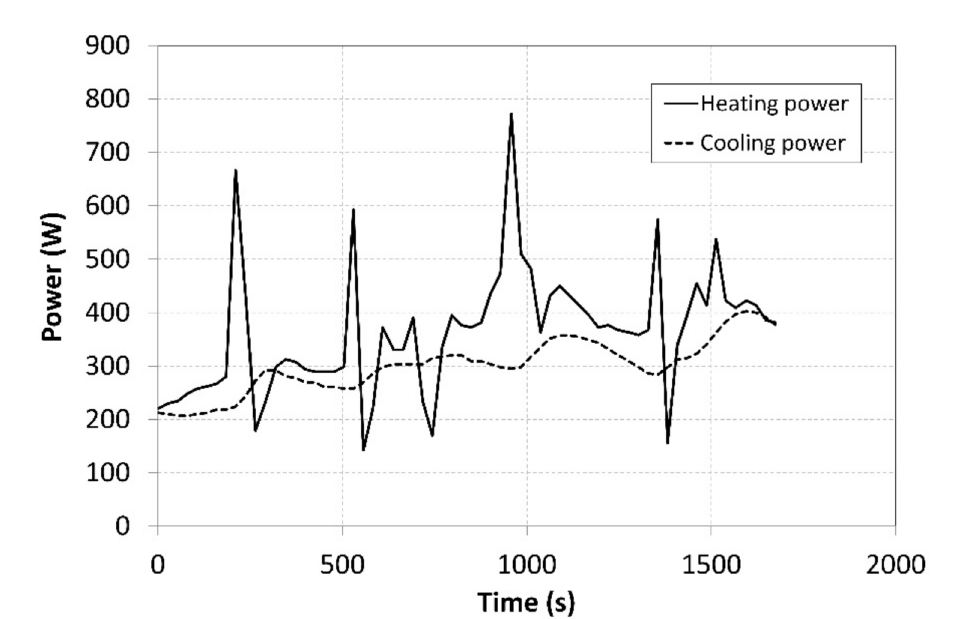
Figure 12. Cooling and heating powers supplied to the